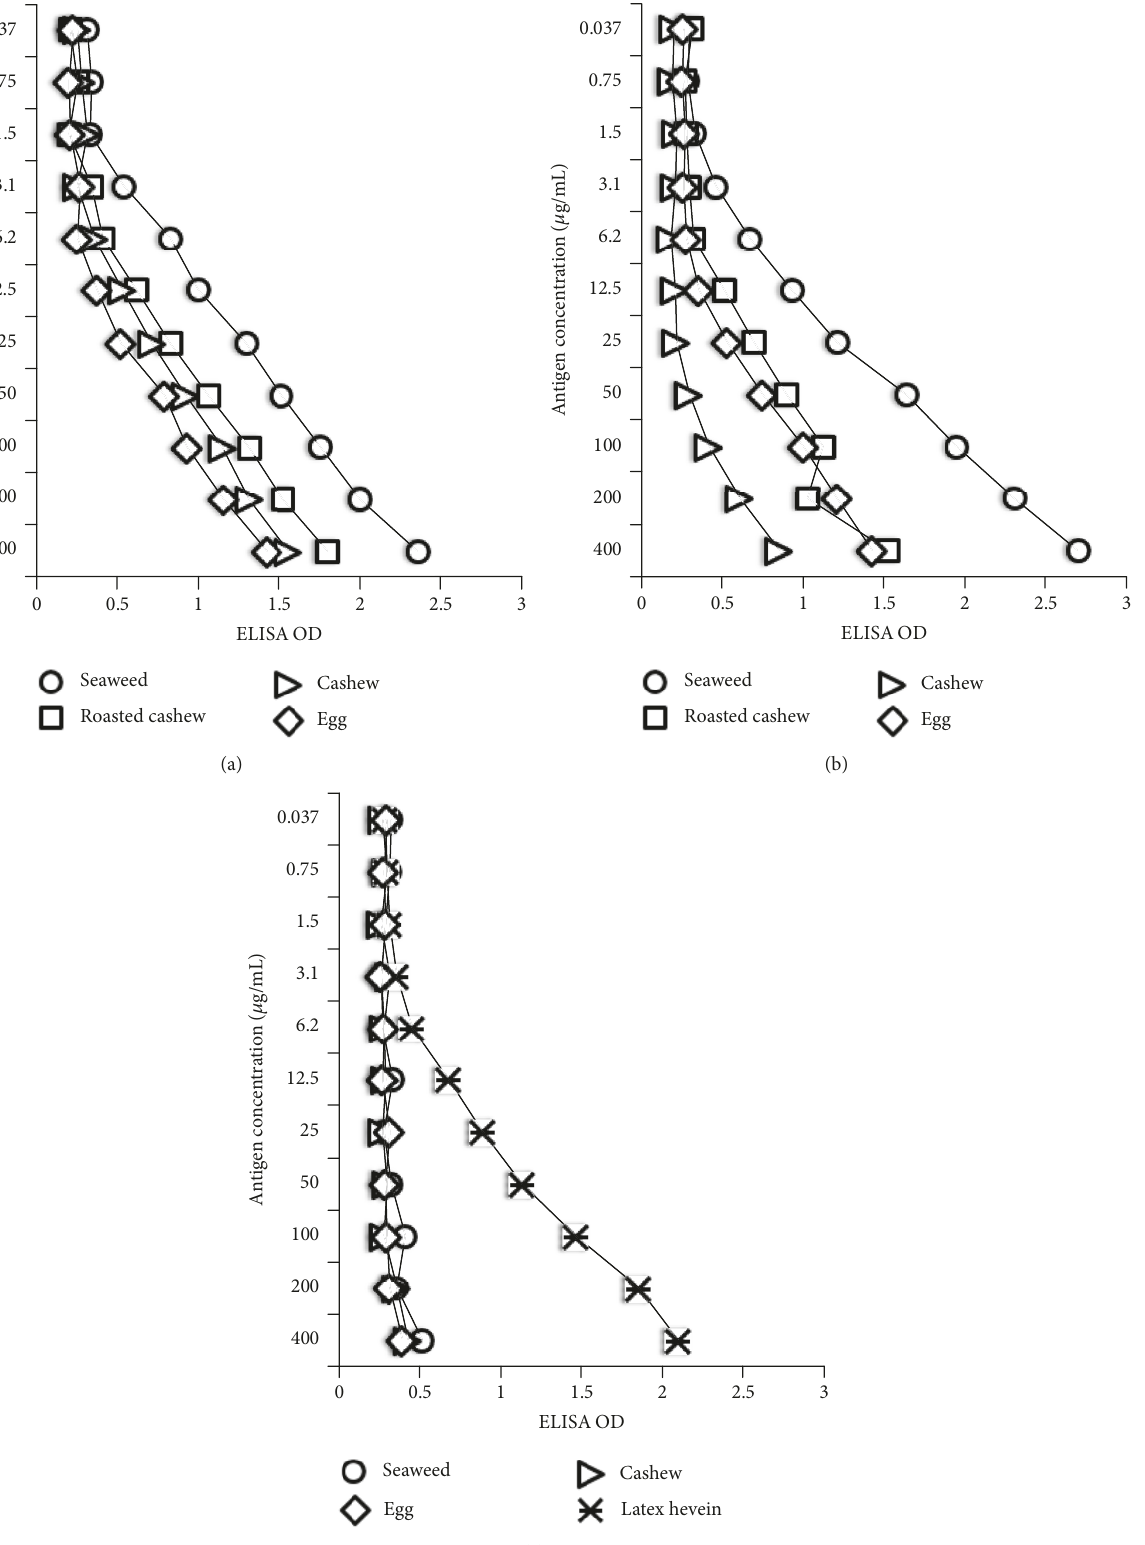
Figure 2: The binding of monoclonal antibody against T3 (a), T4 (b), and Tg (c) to serially diluted food